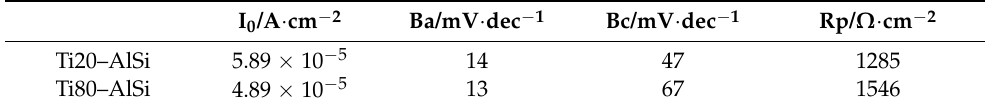
Table 5. Kinetic values obtained from Tafel